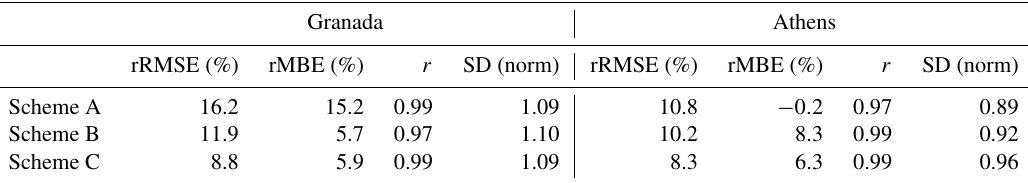
Table 3. Statistical metrics for the modeled global irradiance values versus the reference pyranometer measurements for Granada and Athens and the three schemes applied. Granada